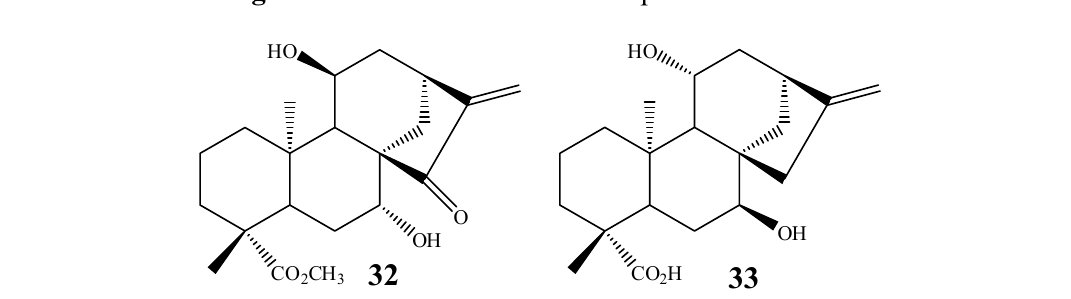
Figure 10. Chemical structures of products 32 and 33 .